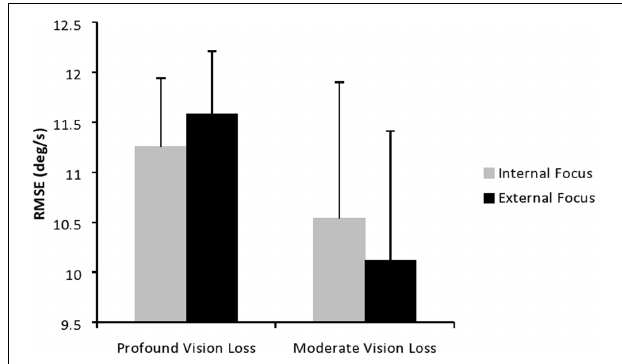
FIGURE 2 | Root mean square error with an internal and external focus of attention.